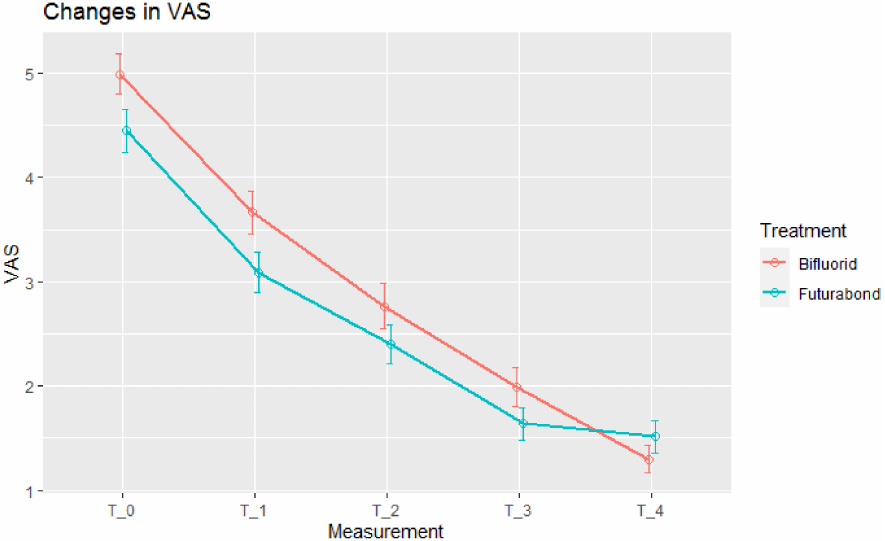
Figure 2. Pain intensity, Visual Analog Scale (VAS) measurements. Means ± std.